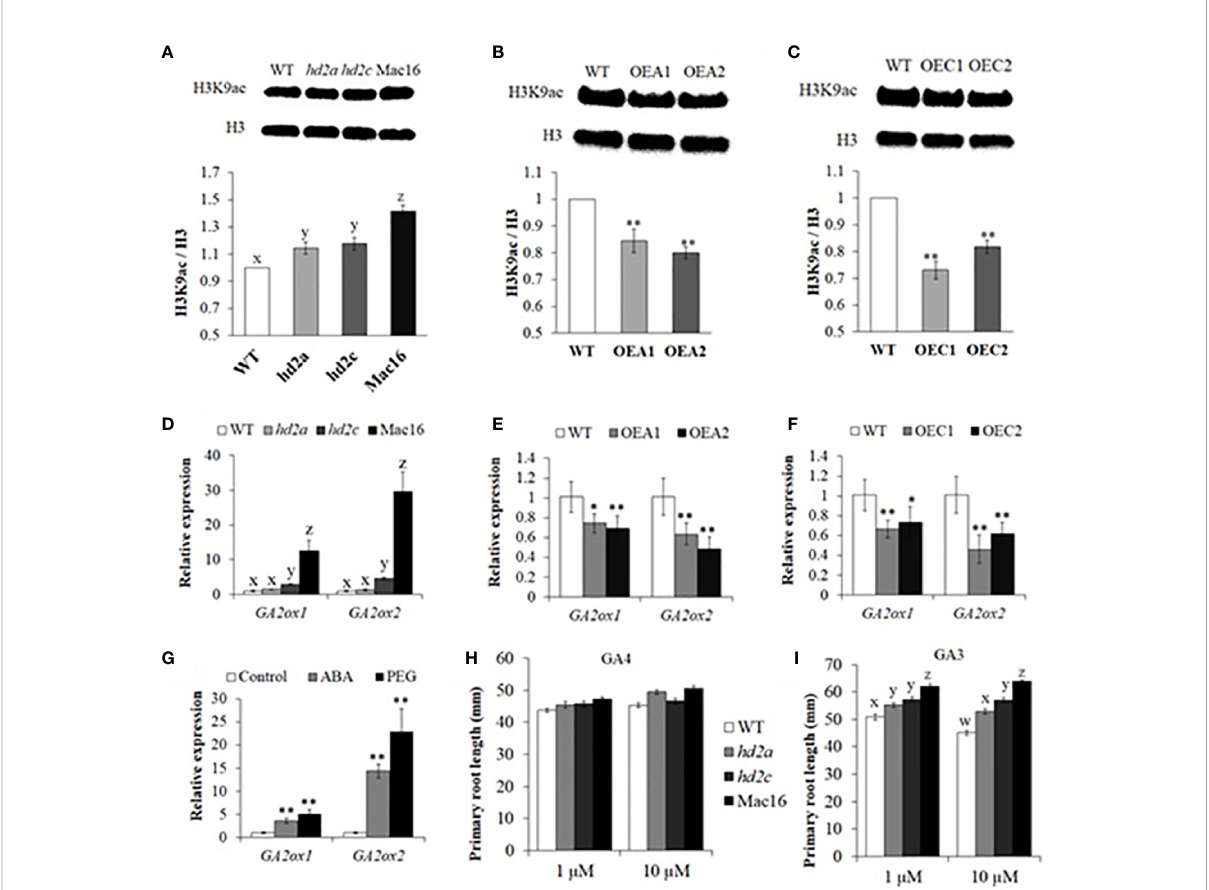
FIGURE 8 HD2A and HD2C decrease H3K9 acetylation level and coregulate root growth via GA2ox-mediated GA catabolism. (A-C) Western blots and relative intensities of H3K9ac/H3 in hd2 mutants (A) , HD2A-OE (B) , and HD2C-OE (C) lines. The fold changes in the relative intensities